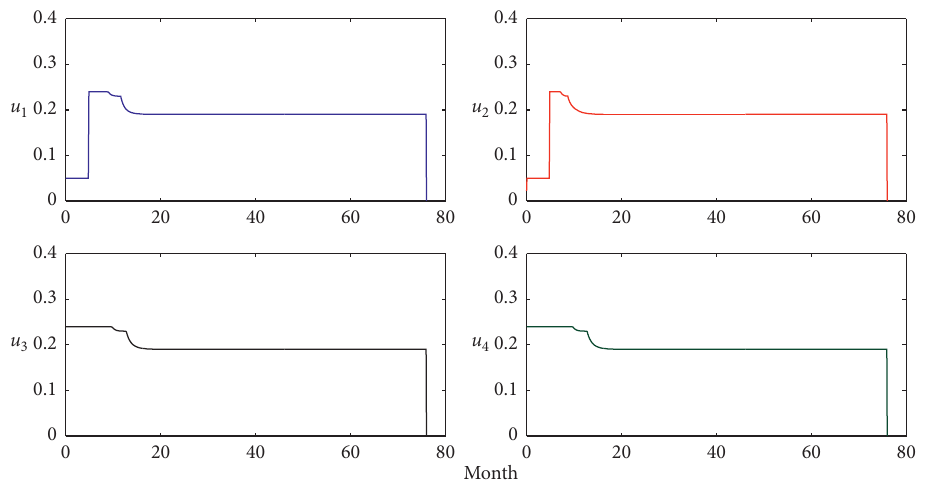
Figure 9: The optimal control variables u